Question: What type of chart is this?
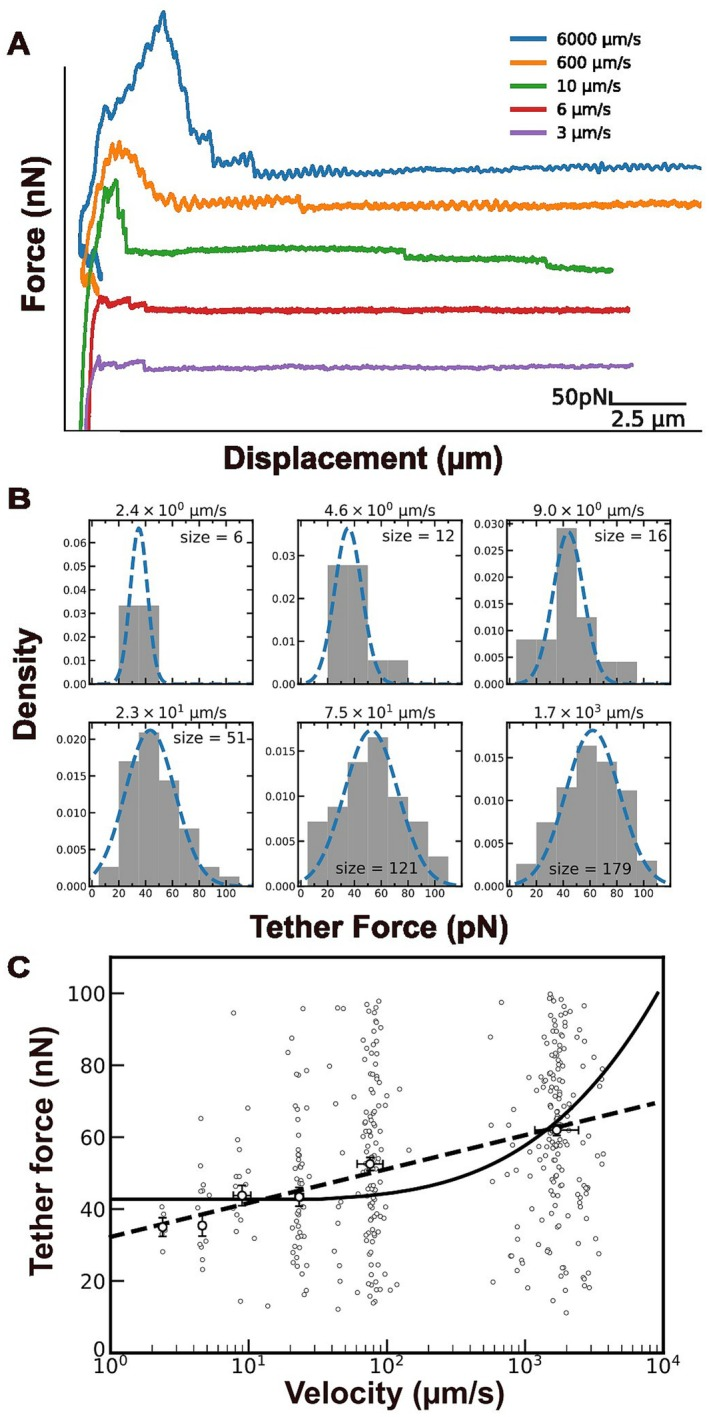
Answer: histogram